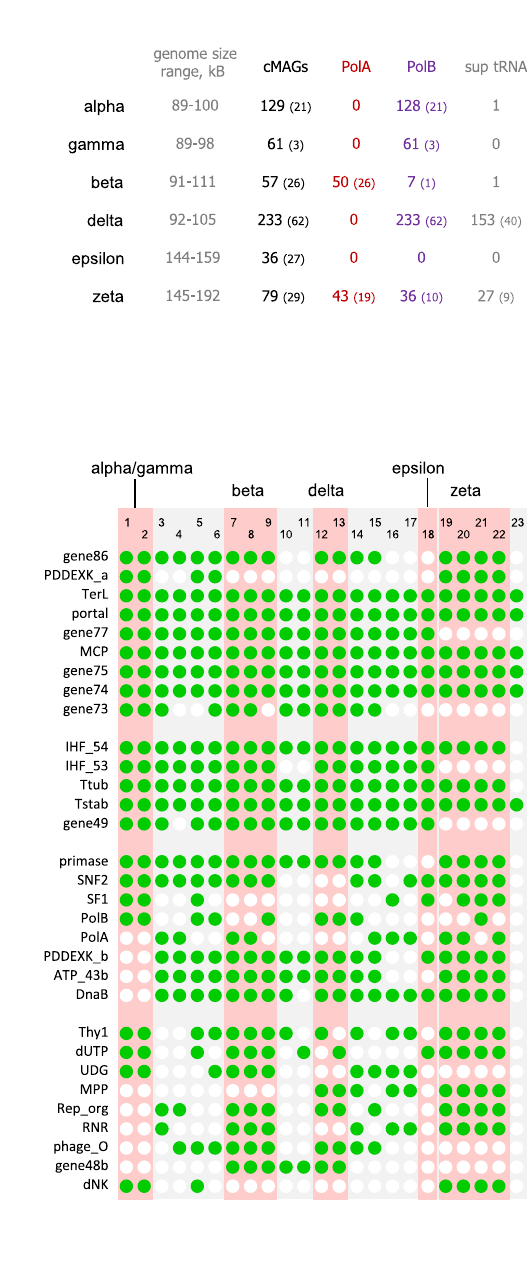
NATURE COMMUNICATIONS| (2021) 12:1044 |https://doi.org/10.1038/s41467-021-21350-w|www.nature.com/naturecommunications